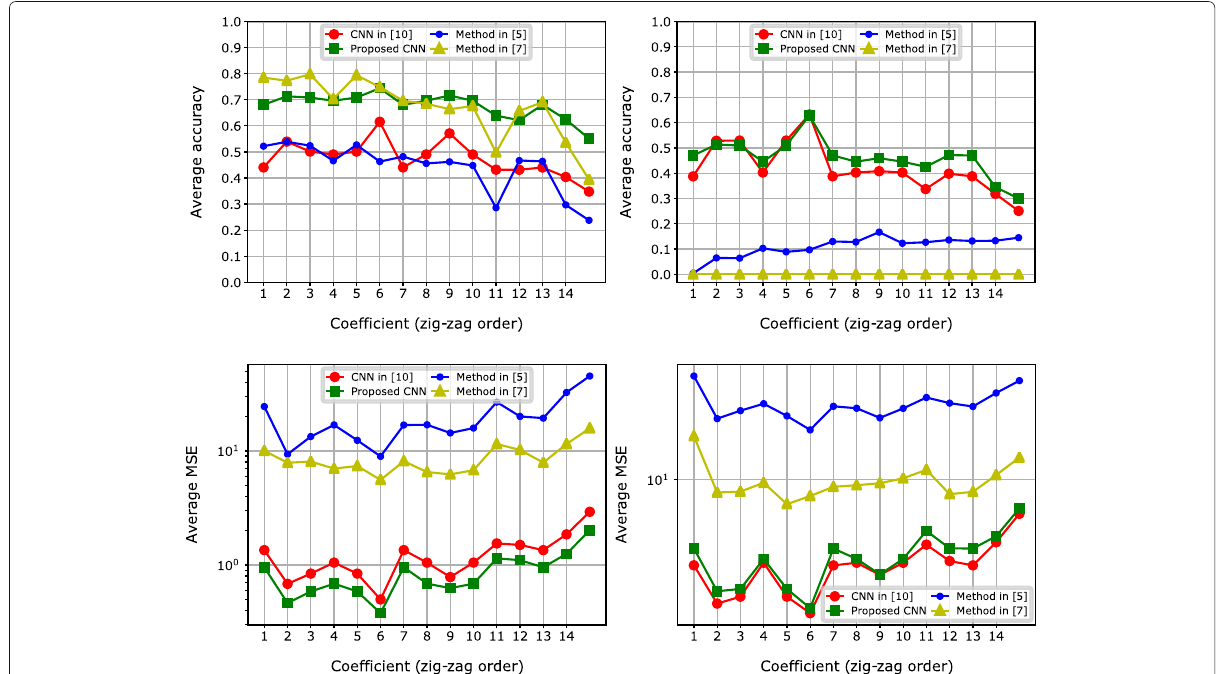
Fig. 5 Average accuracy when QF 1 < QF 2 (top left) and when QF 1 ≥ QF 2 (top right), average MSE when QF 1 < QF 2 (bottom left) and when QF 1 ≥ QF 2 (bottom right) of the estimation for each of the 15 DCT coefficients, for QF 2 = 90, in aligned DJPEG scenario